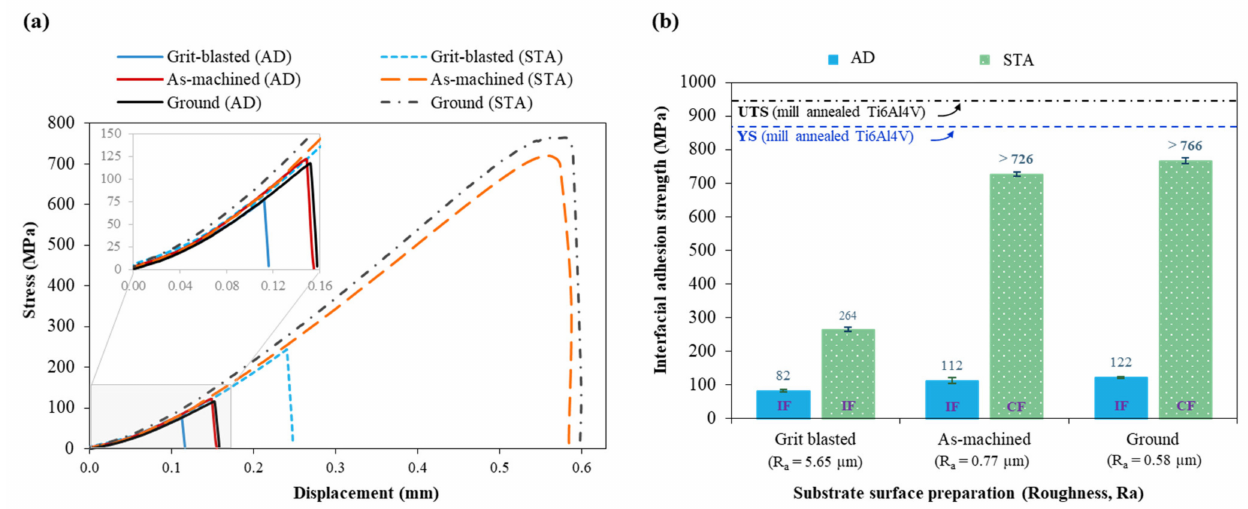
Figure 4. Effect of STA on the interfacial adhesion strength for different substrate surface preparations: ( a ) stress vs. displacement curve, showing one example for each condition; ( b ) interfacial adhesion strength (average of three tests). (Note: AD-As-deposited, STA-Solution Treated and Aged, IF-Interface Failure, CF-Cohesion Failure).